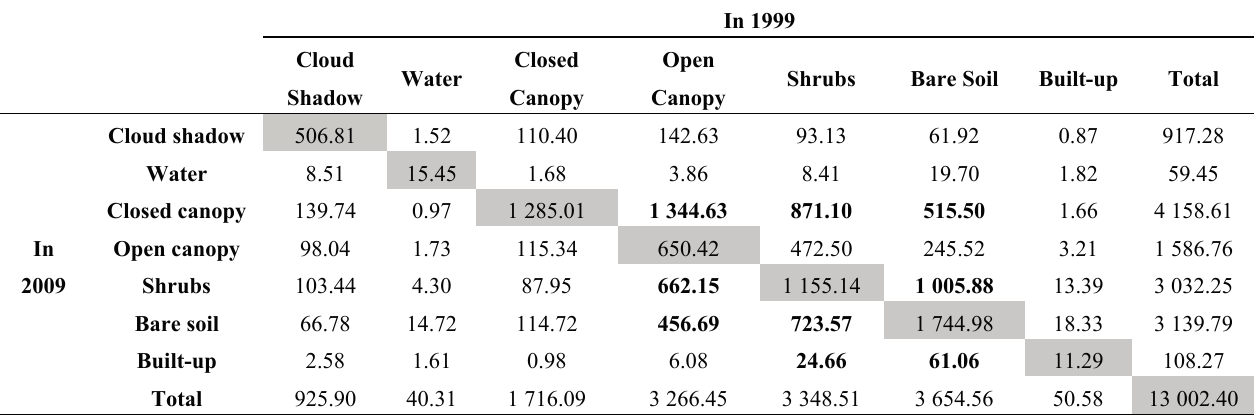
Table 5. Transitions of land-cover types in the region, 2000 to 2009 (km 2 ).